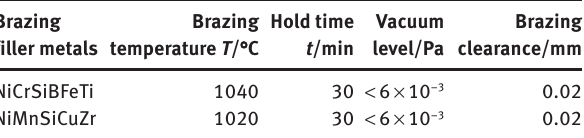
Table 2: Process parameters of brazing.